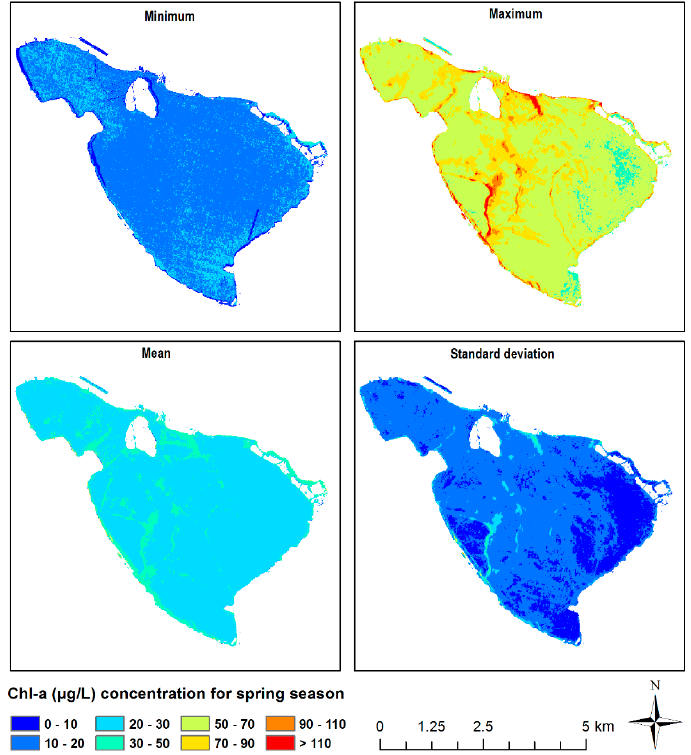
Figure A6. Chl- a concentration for a spring season. ISPRS Int. J. Geo-Inf. 2020 , 9 , 143